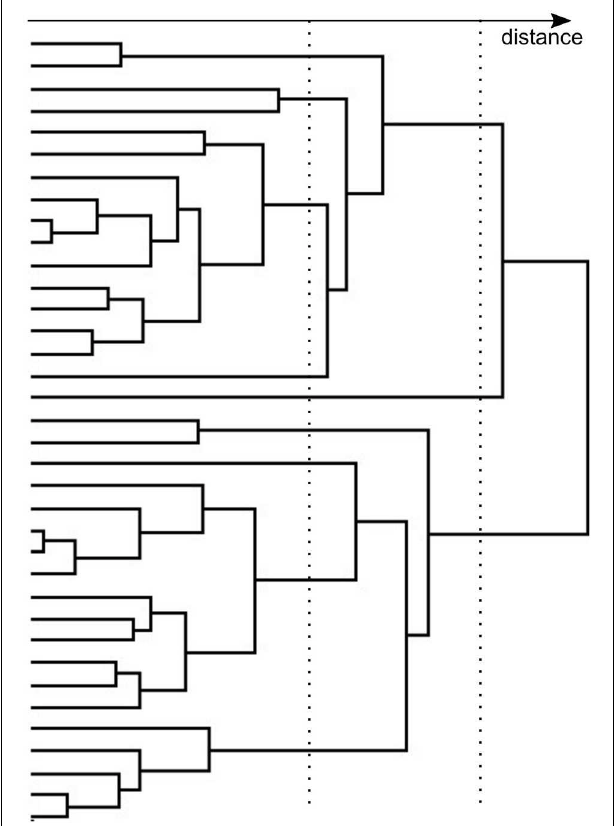
FIGURE 3 | An example of a dendrogram. Distance between two horizontal branches is going from left to right. The two dashed lines illustrates two cuts yielding 9 or 3